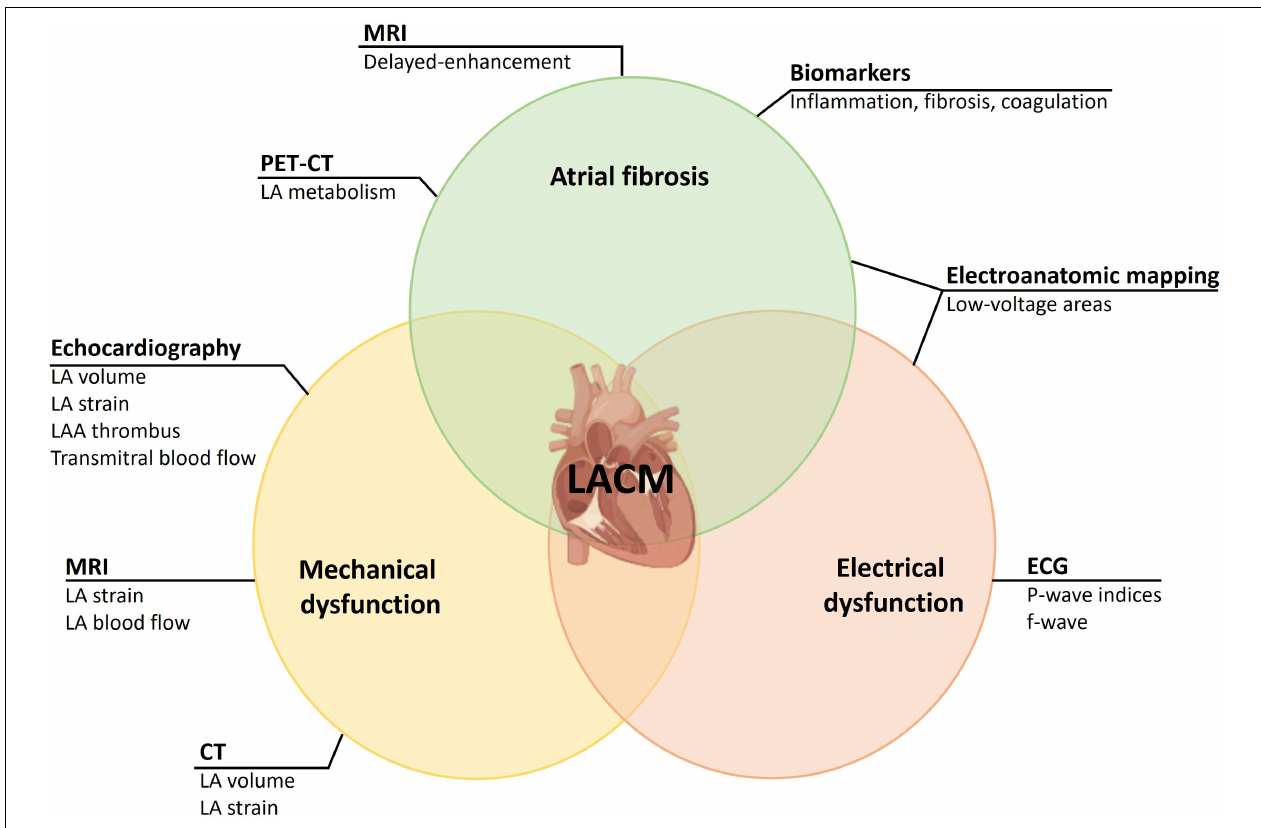
FIGURE 1 | Illustration of LACM as a composite entity of atrial fibrosis, mechanical dysfunction, and electrical dysfunction. Assessment of entities is achieved through different methods. CT, computed tomography; ECG, electrocardiology; f-wave, fibrillatory wave; LA, left atrial/let atrium; LAA, left atrial appendage; LACM, left atrial cardiomyopathy; MRI, magnetic resonance imaging; PET-CT, cardiac positron emission tomography – computed